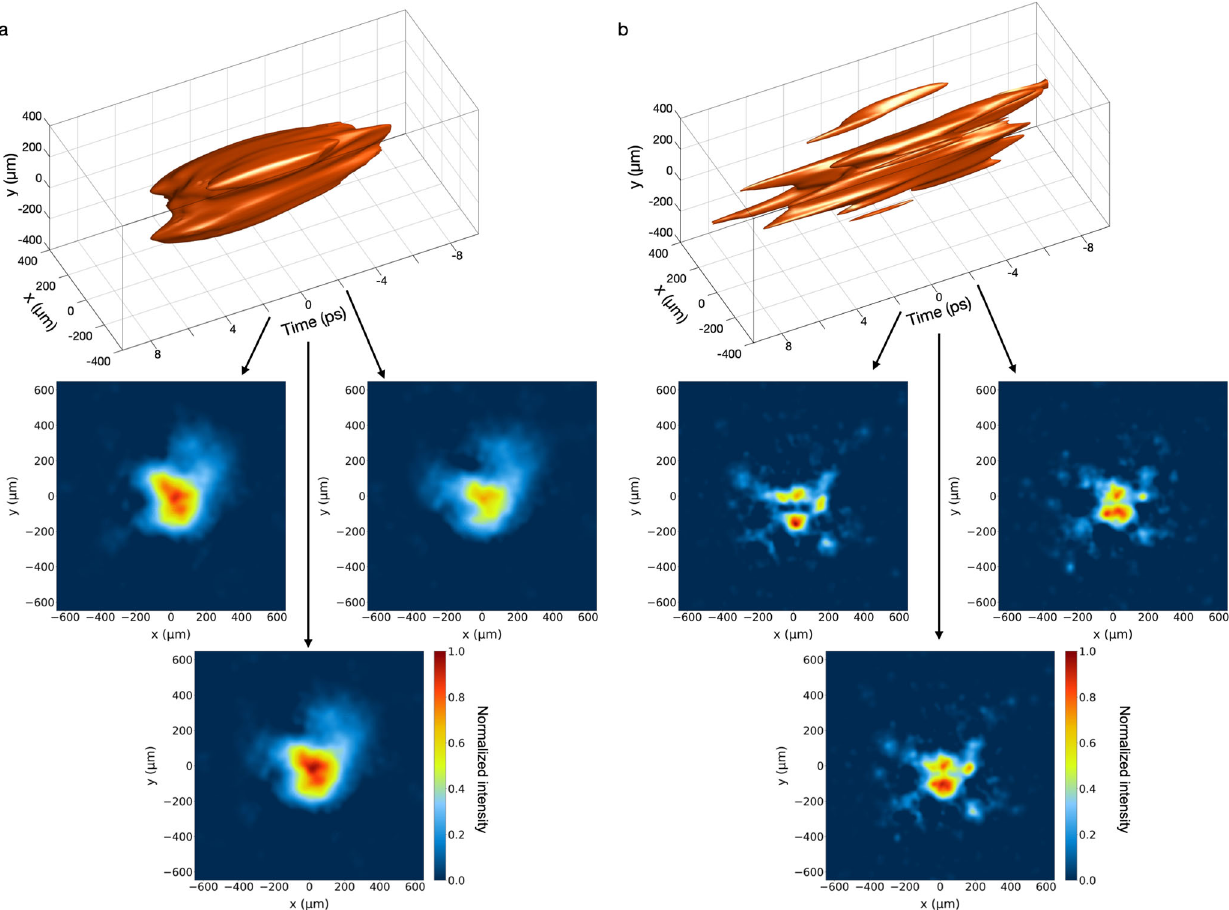
Fig. 4 Spatiotemporal distributions of example pulses with intensities lower than rogue wave threshold. a , b Reconstructed spatiotemporal intensity distributions of two example pulses with intensities lower than rogue wave threshold. These plots are achieved by calculating a contour from the beam pro fi les at each temporal point. Spatial distributions around the peaks of the pulses are presented separately by normalizing to local maxima and are show in insets connected to the main panel by